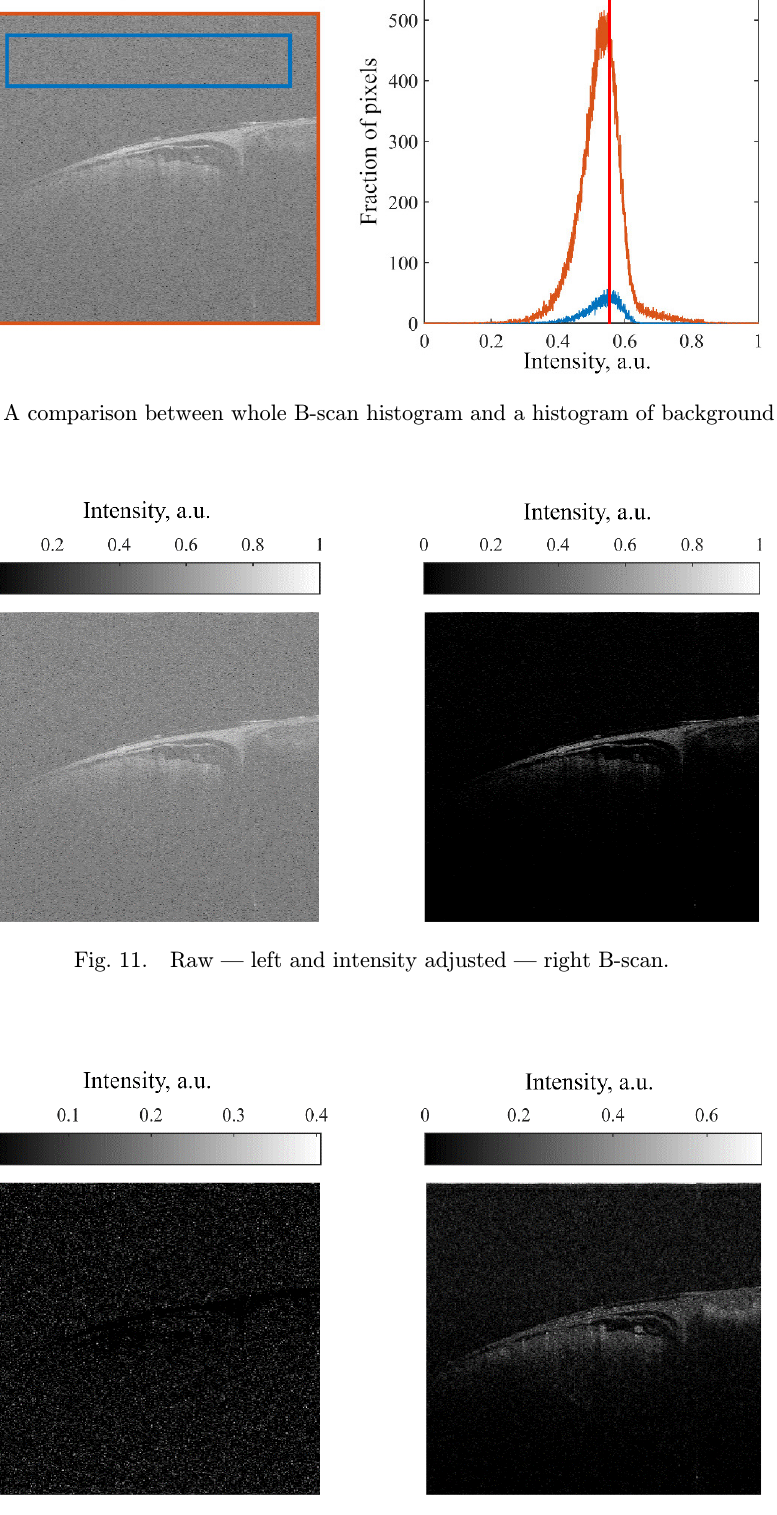
Fig. 12. Speckle variance maps computed before (left) and after (right) intensity adjustment algorithm.